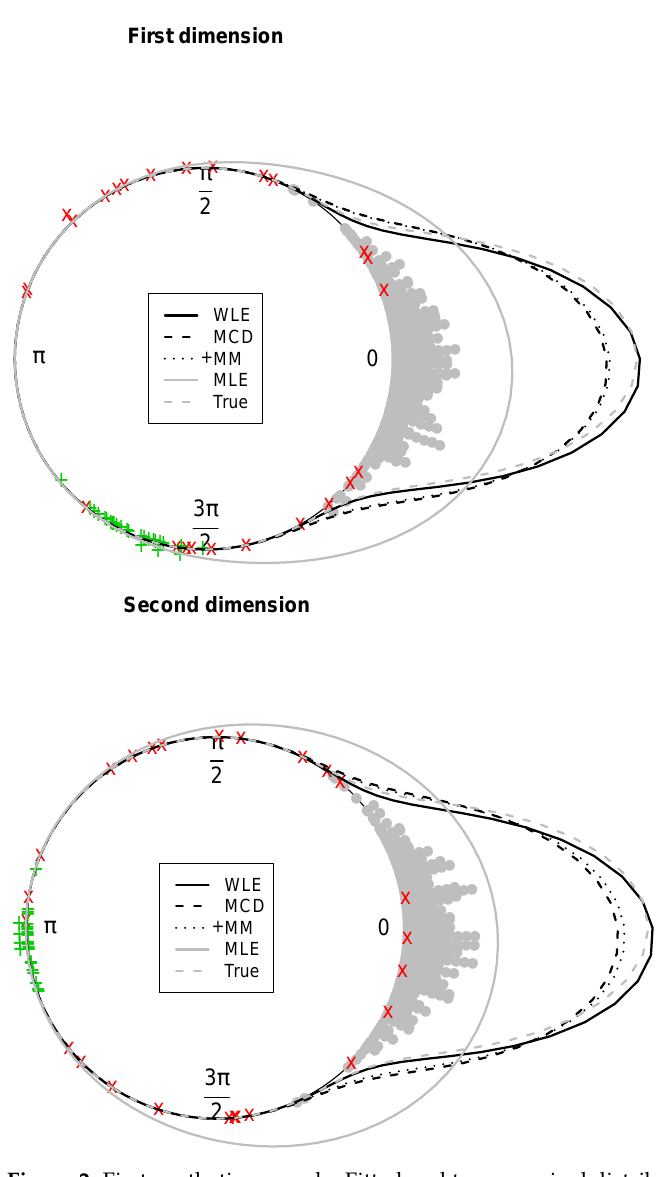
Figure 2. First synthetic example. Fitted and true marginal distributions on the unit